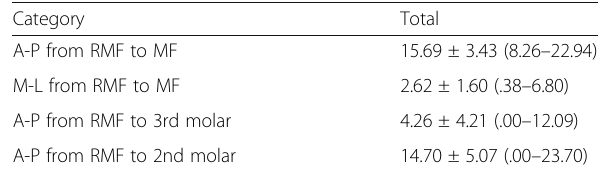
Table 3 The distribution of canal type presence in each side Side